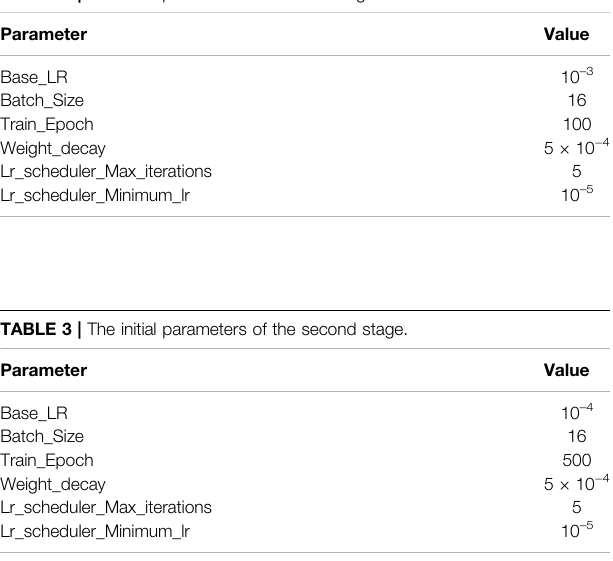
TABLE 2 | The initial parameters of the fi rst stage.